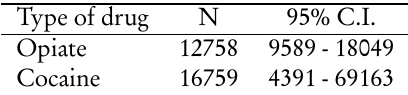
Analytically estimated population size (N) and 95% confidence interval (C.I.) obtained on the real dataset (Liguria region 2002) by the proposed Poisson LLM.